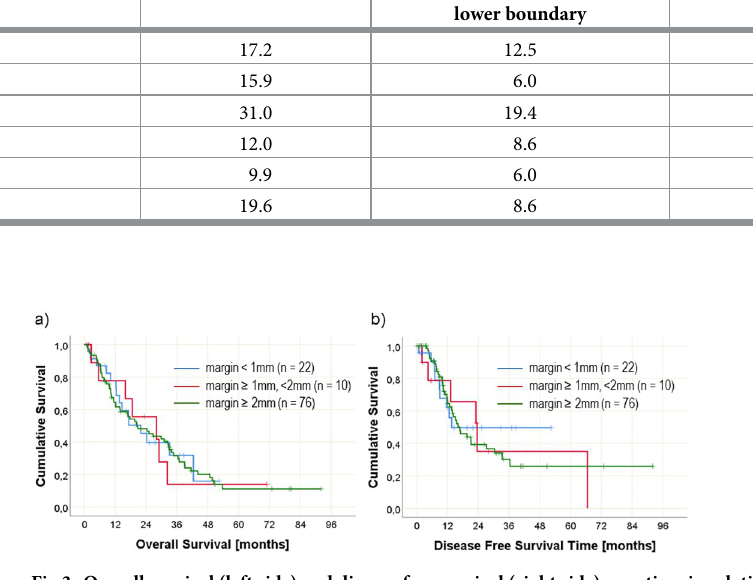
Fig 3. Overall survival (left side) and disease-free survival (right side) over time in relation to involvement of the posterior resection margin for three different resection margin distances. Numbers at risk are given in brackets.